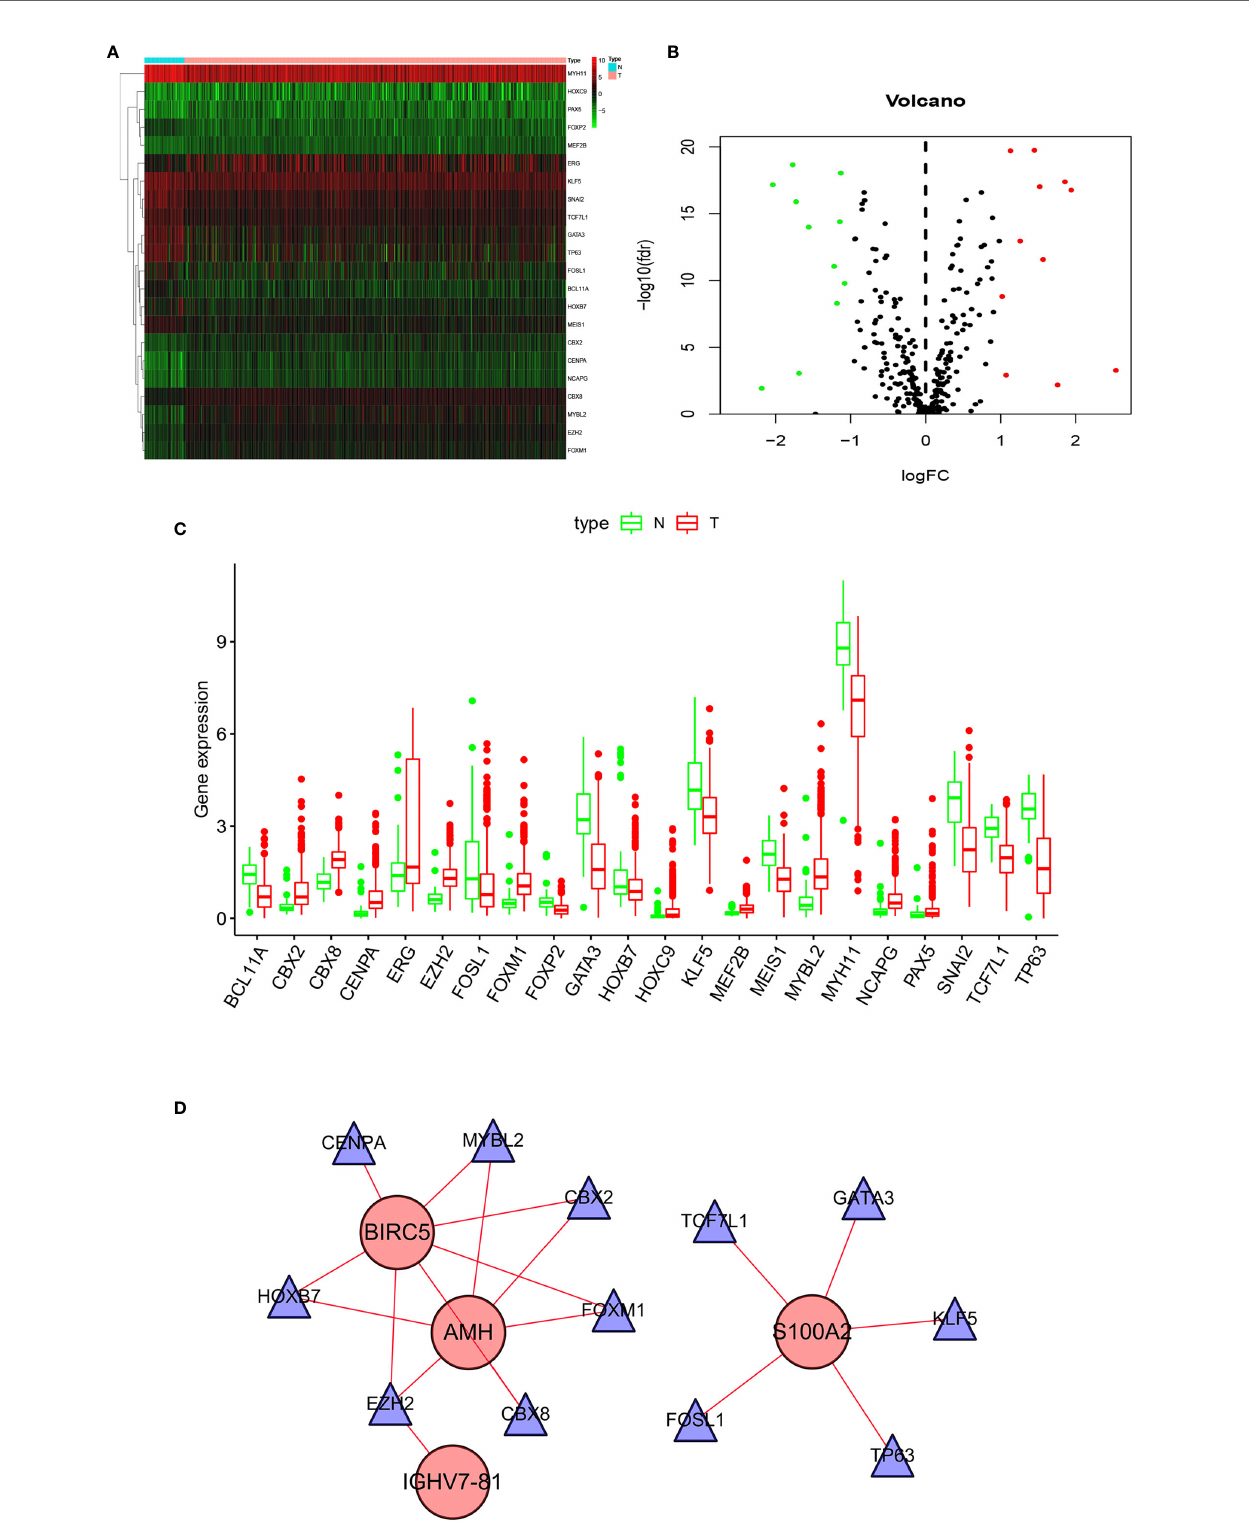
FIGURE 3 | Differentially expressed TFs: (A) Heatmap, (B) Volcano map, and (C) Boxplots. (D) The network shows the relationship between TFs and ARGs.